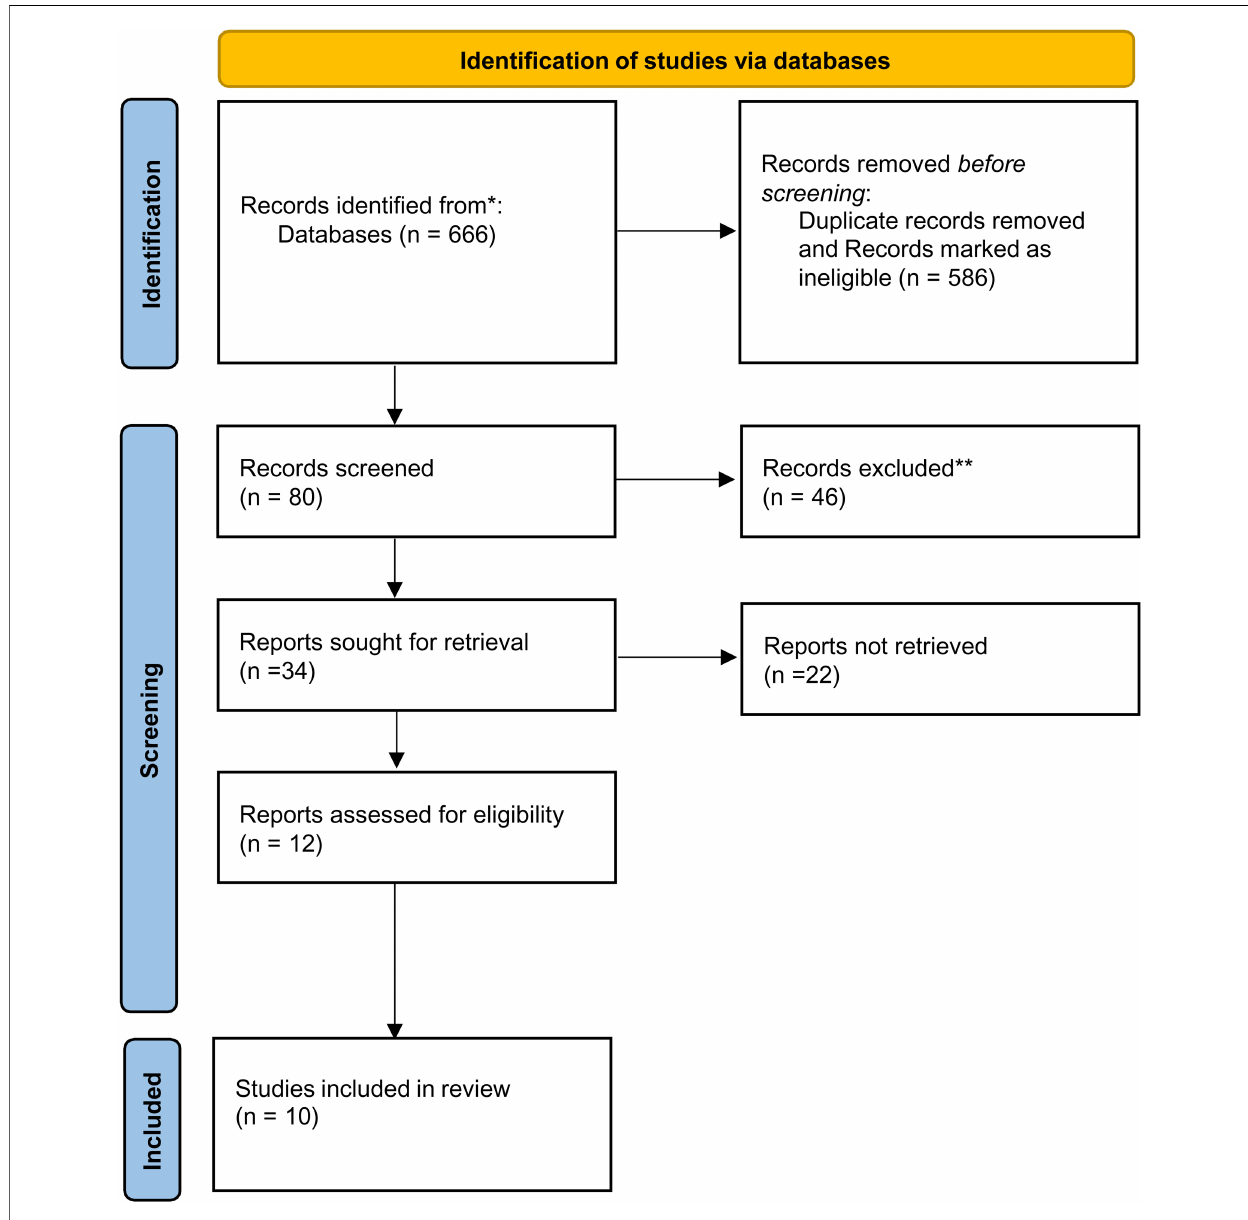
FIGURE 1 Prisma diagram to screen articles. Page MJ, McKenzie JE, Bossuyt PM, Boutron I, Hoffmann TC, Mulrow CD, et al. The PRISMA 2020 statement: an updated guideline for reporting systematic reviews. BMJ 2021;372:n71. doi: